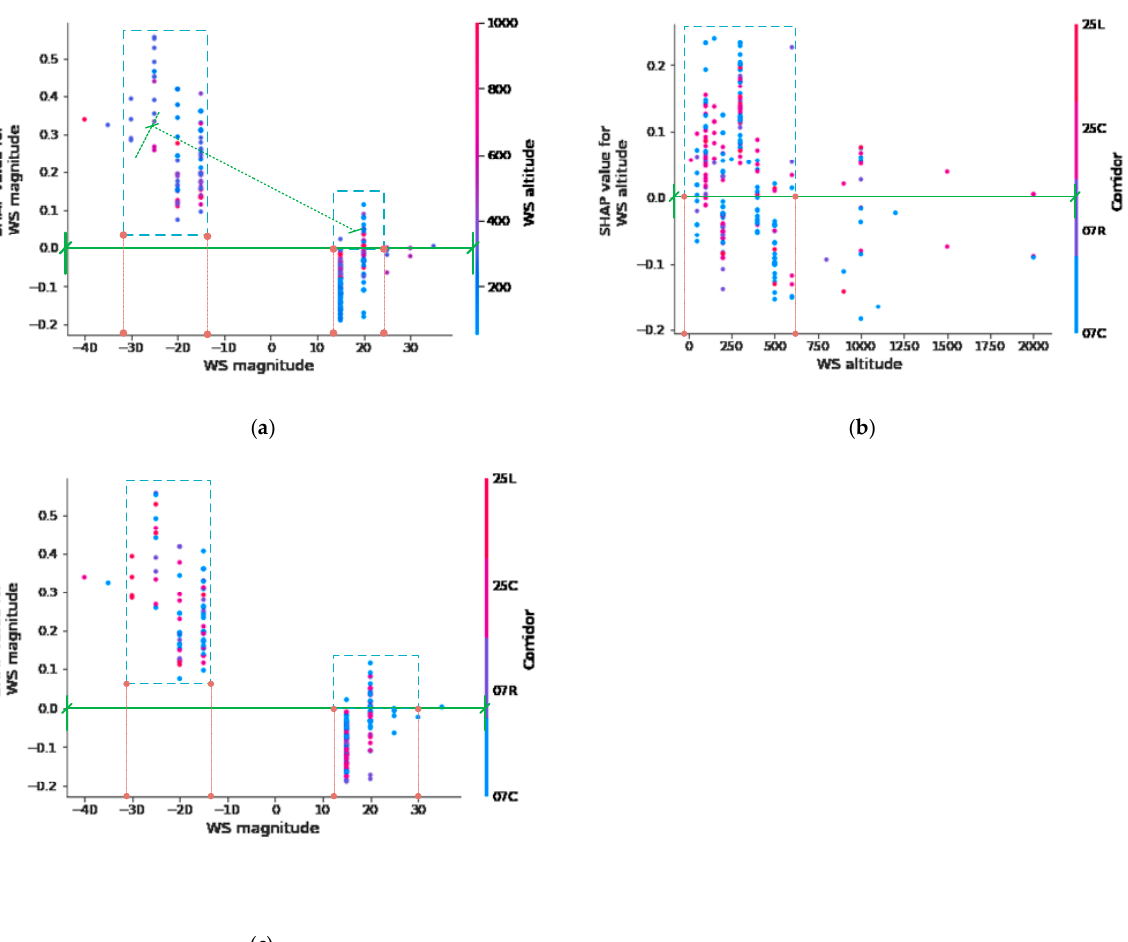
Figure 9. ( a ) SHAP WS magnitude vs. WS altitude plot. ( b ) SHAP WS altitude vs. Corridor plot. ( c ) SHAP WS magnitude vs. Corridor plot.